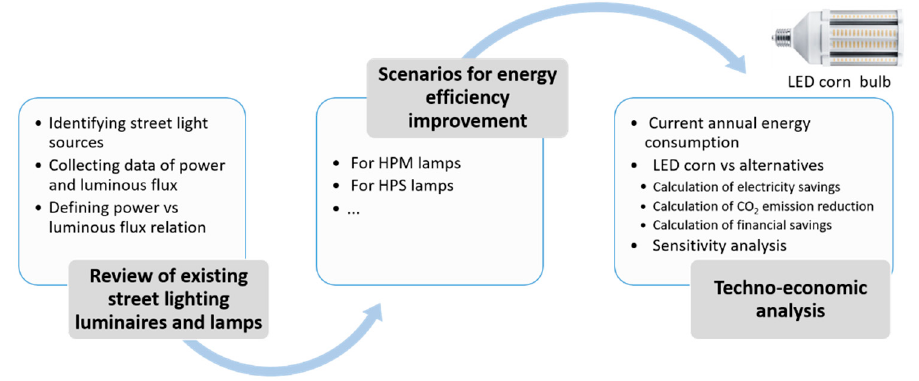
Figure 1. Methodology for estimating the techno-economic effects of the implementation of energy efficiency measures in the street lighting system.